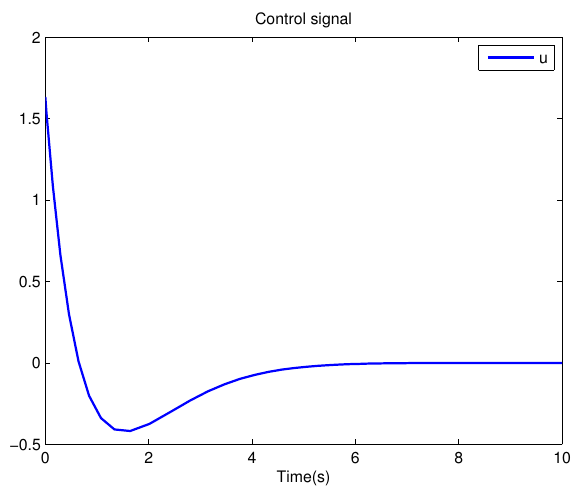
Figure 8. Robust control signal.